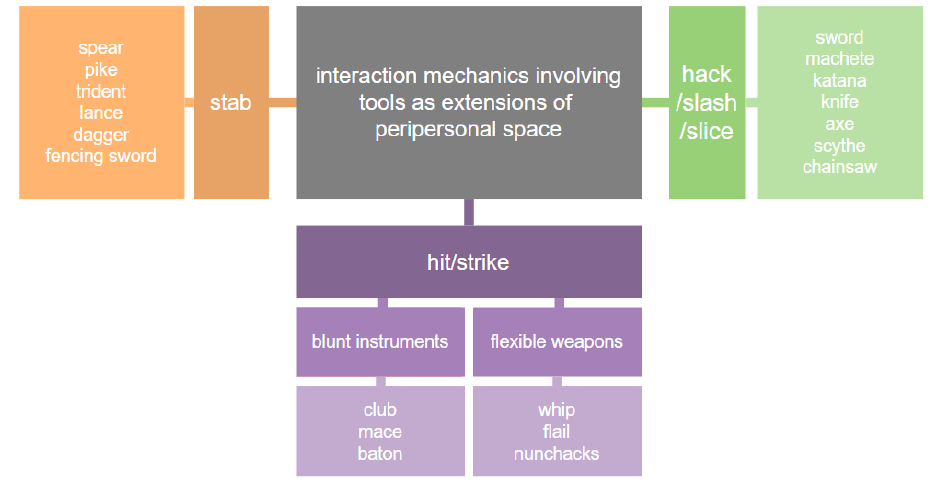
Figure 2. Specific examples of interaction mechanics based on tools as extensions of periper- sonal